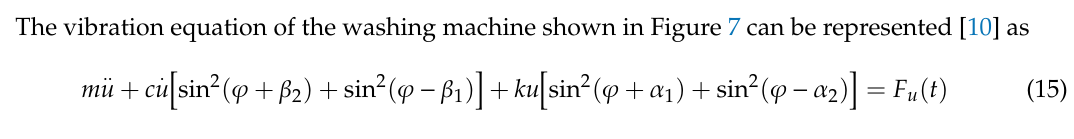
Figure 7. A 2D mechanical modeling of the washing machine.